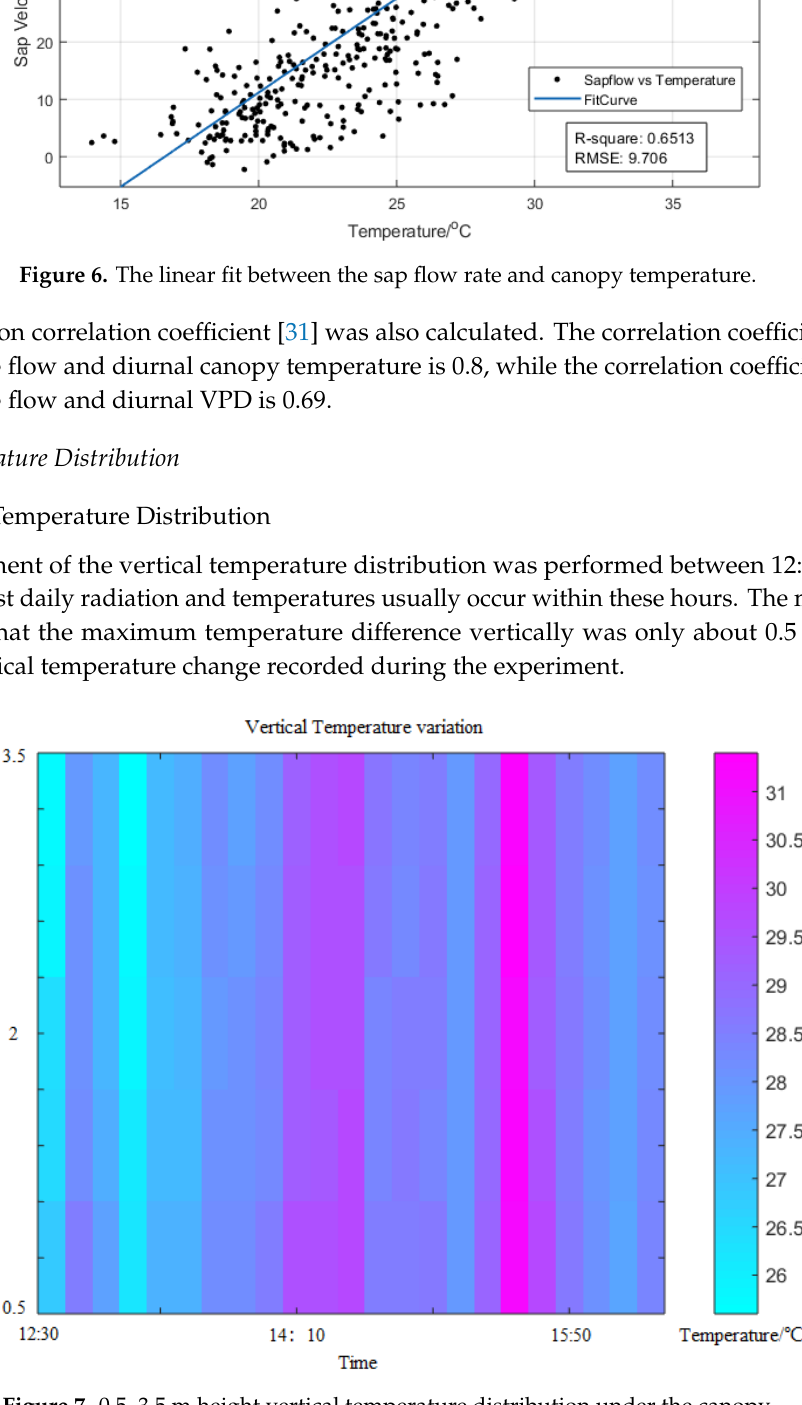
Figure 5. The non-linear fit between the sap flow rate and VPD.